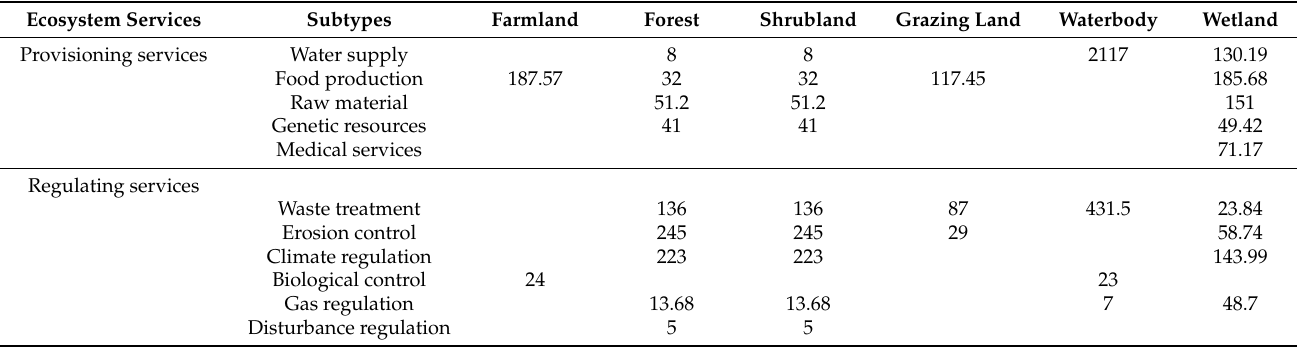
Table 4. Ecosystem service functions and their modified local value coefficients